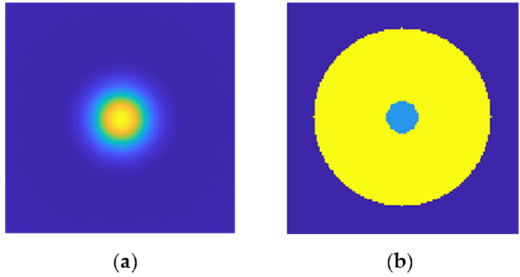
Figure 14. Critical areas of the image taken into account in the neural network database preparation. ( a ) The original image with clearly visible defect localization, ( b ) two critical areas: light blue—the defect area, and yellow—non−defect area.